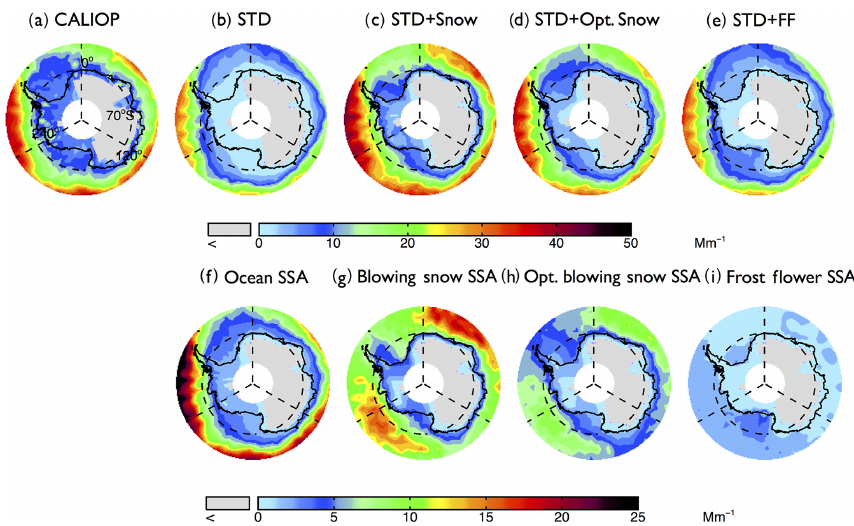
Figure 4. Spatial distributions of mean aerosol extinction coefficients (0–2km) during the 2007–2009 Antarctic cold season (May–October), (a) observed by CALIOP and calculated with the GEOS-Chem ( b : STD, c : STD + Snow, d : STD + Opt. Snow, e : STD + FF). The bottom panels show the extinction of individual aerosol components in the GEOS-Chem simulations: (f) open ocean SSA, (g) blowing snow SSA, (h) Opt. blowing snow SSA, and (i) frost flower SSA. Note the different color-bar scales for the top and bottom